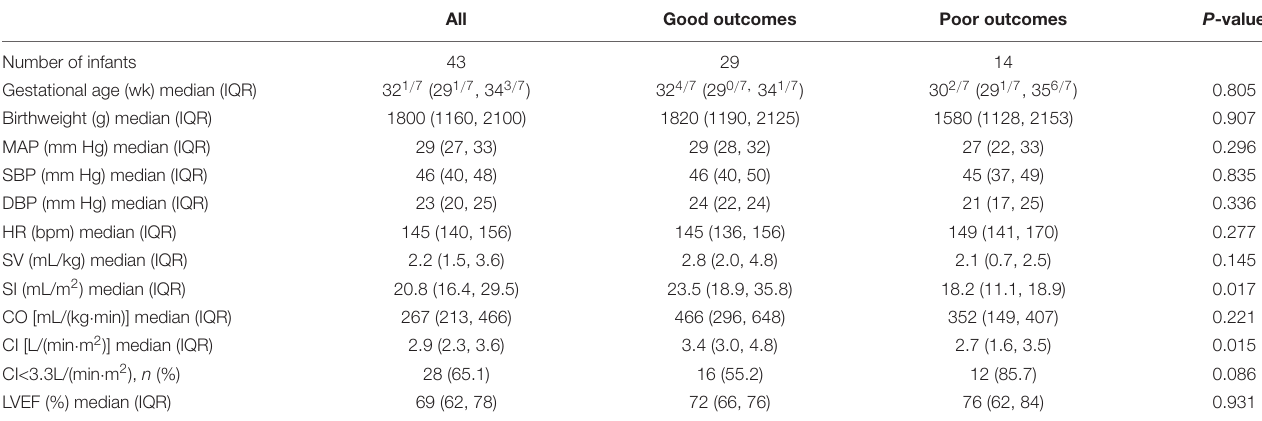
TABLE 4 | Comparison of baseline parameters in infants with good and poor outcomes. All Good outcomes Poor outcomes P